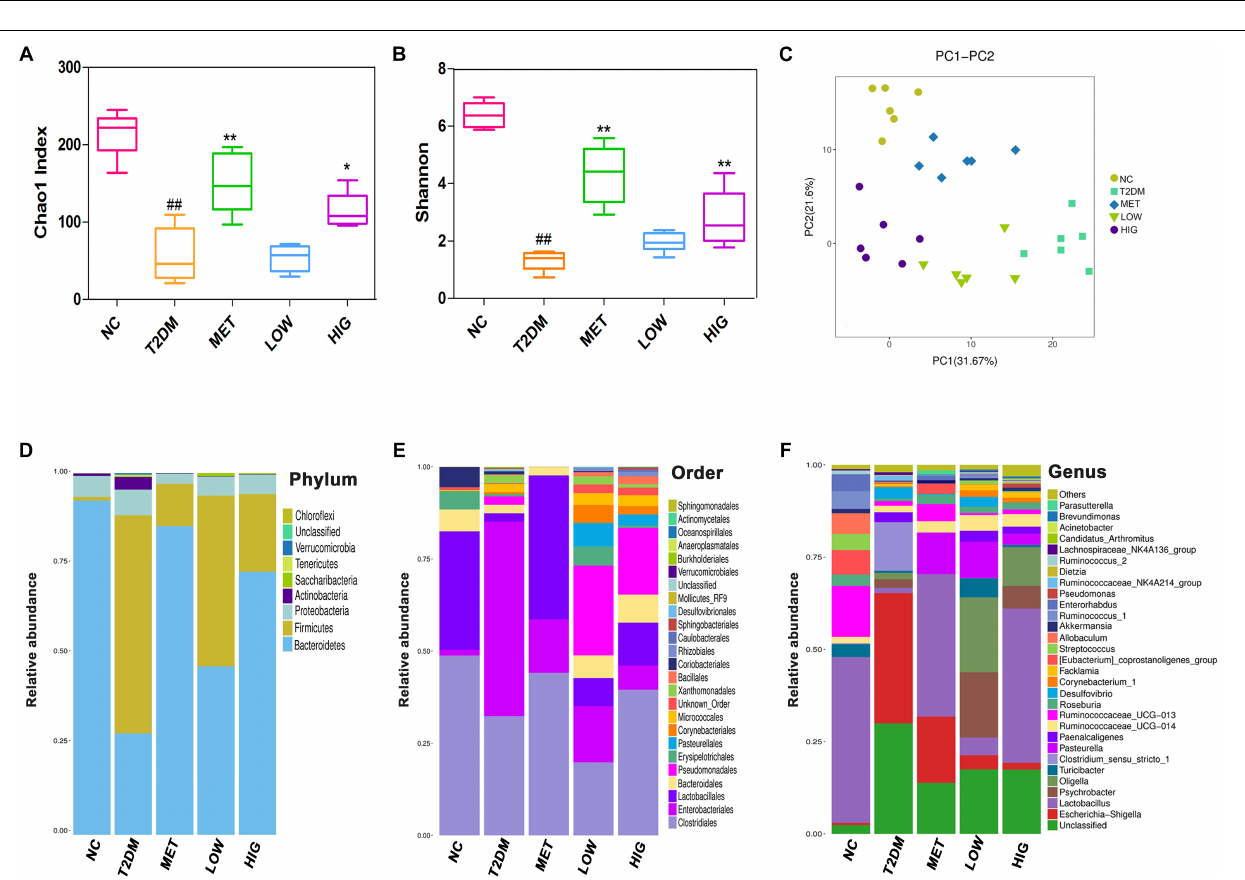
FIGURE 5 | Effect of RAGP treatment on gut microbiome composition of rats in each group ( n = 6). (A) Bacterial richness, (B) diversity index, (C) principal component analysis (PCA) graphs and microbial community changes at (D) phylum level, (E) order level, and (F) genus level were obtained from ileum fecal samples and analyzed using QIIME. Values are mean ± SD, # P < 0.05, ## P < 0.01 vs. NC group; ∗ P < 0.05, ∗∗ P < 0.01vs. T2DM group.